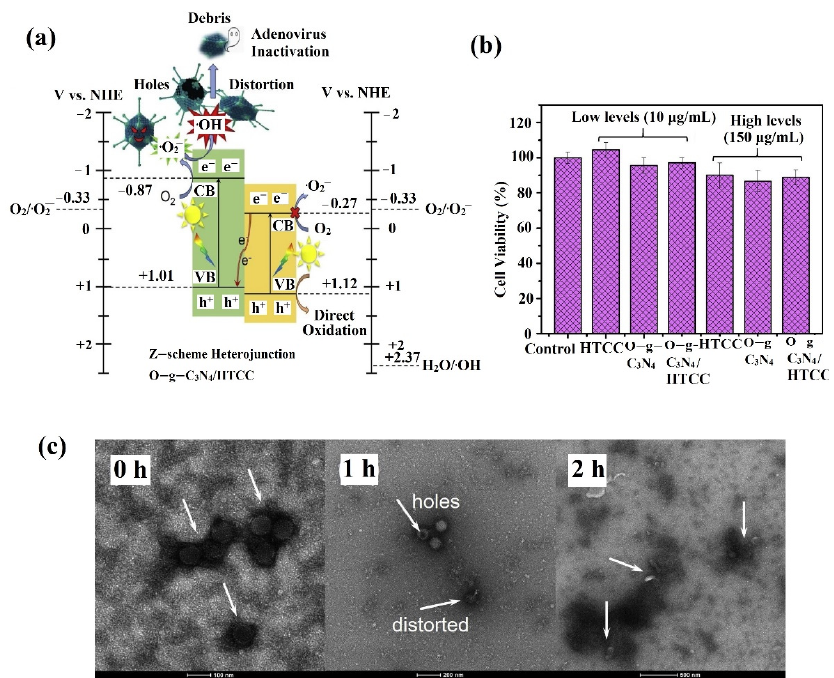
Figure 4. ( a ) The plausible charge transfer route in photocatalysis over the O-g-C 3 N 4 /HTCC Z- scheme heterojunction; ( b ) cytotoxic effects of O-g-C 3 N 4 /HTCC, and O-g-C 3 N 4 ; and ( c ) TEM images of HAdV-2 mixed with O-g-C 3 N 4 /HTCC taken during different intervals of time. Reproduced with permission from [31] with license number 5136341407889. Copyright Elsevier 2021.